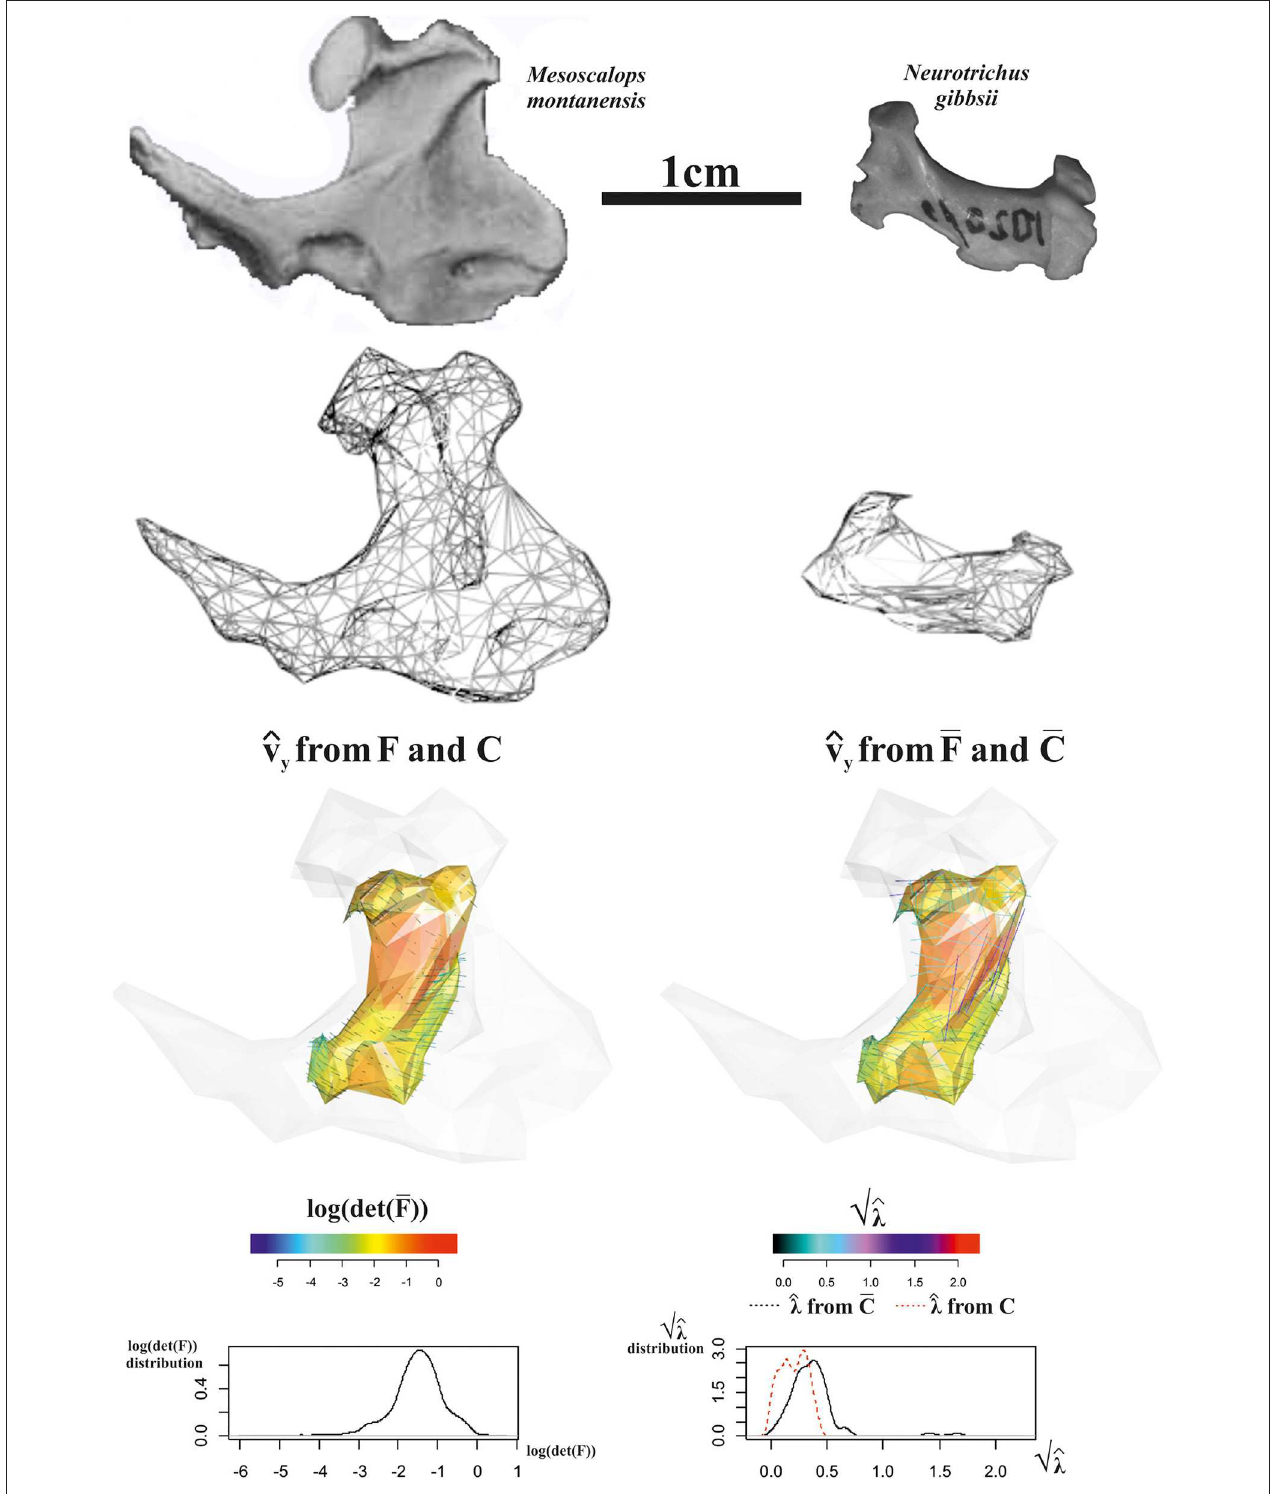
FIGURE 13 | Local deformations observable between Mesoscalops montanensis UWBM 54708 (as source) and Neurotrichus gibbsii LACM 093944 (as target). 3D meshes are also shown. v y calculated upon F or F are shown and colored according to the corresponding ˆ log(det( F )). Densities of relevant metrics are also illustrated. Source and target shapes were aligned via OPA without scaling. UWBM, University of Washington,